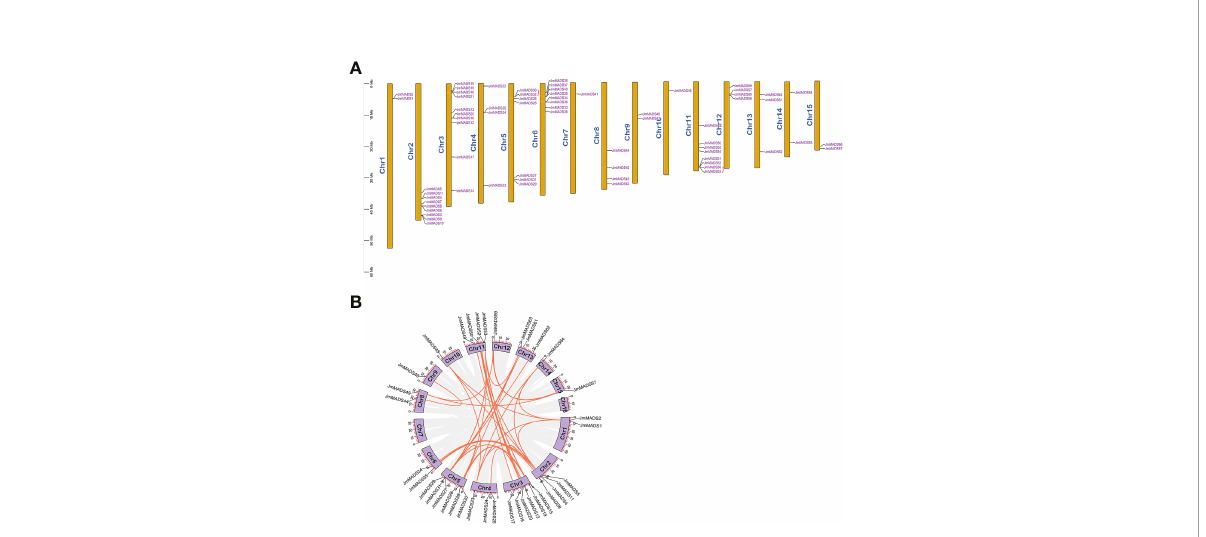
FIGURE 3 The chromosomal distribution and synteny blocks of JmMADS genes. (A) The 15 chromosomes (chromosomes 1 to 15) of J. mandshurica labeled with JmMADS gene names. Tandemly duplicated genes are marked with red arcs. (B) Genomic localization and gene duplication of JmMADS genes on J. mandshurica chromosomes. Gray lines indicate all syntenic blocks in the J. mandshurica genome; orange lines indicate the interchromosomal relationships of JmMADS